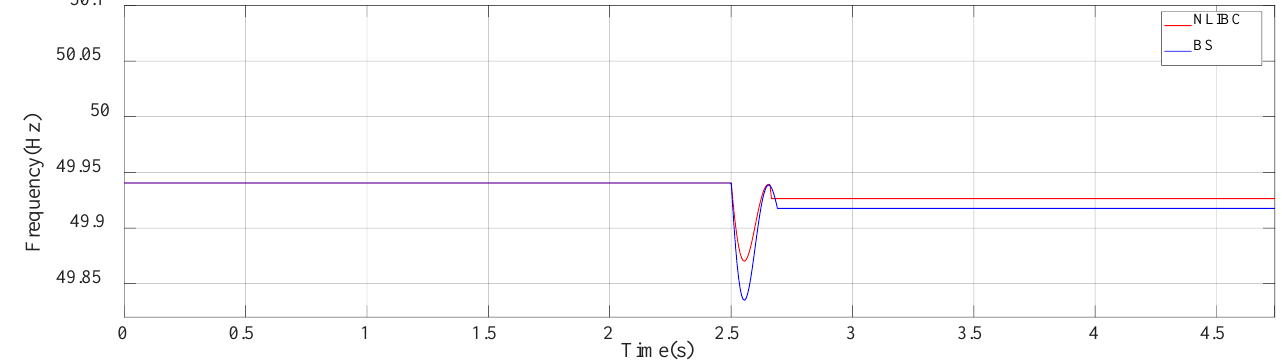
Figure 29. comparison of NLIBC and BS for frequency regulation. Figure 29. Comparison of NLIBC and BS for frequency